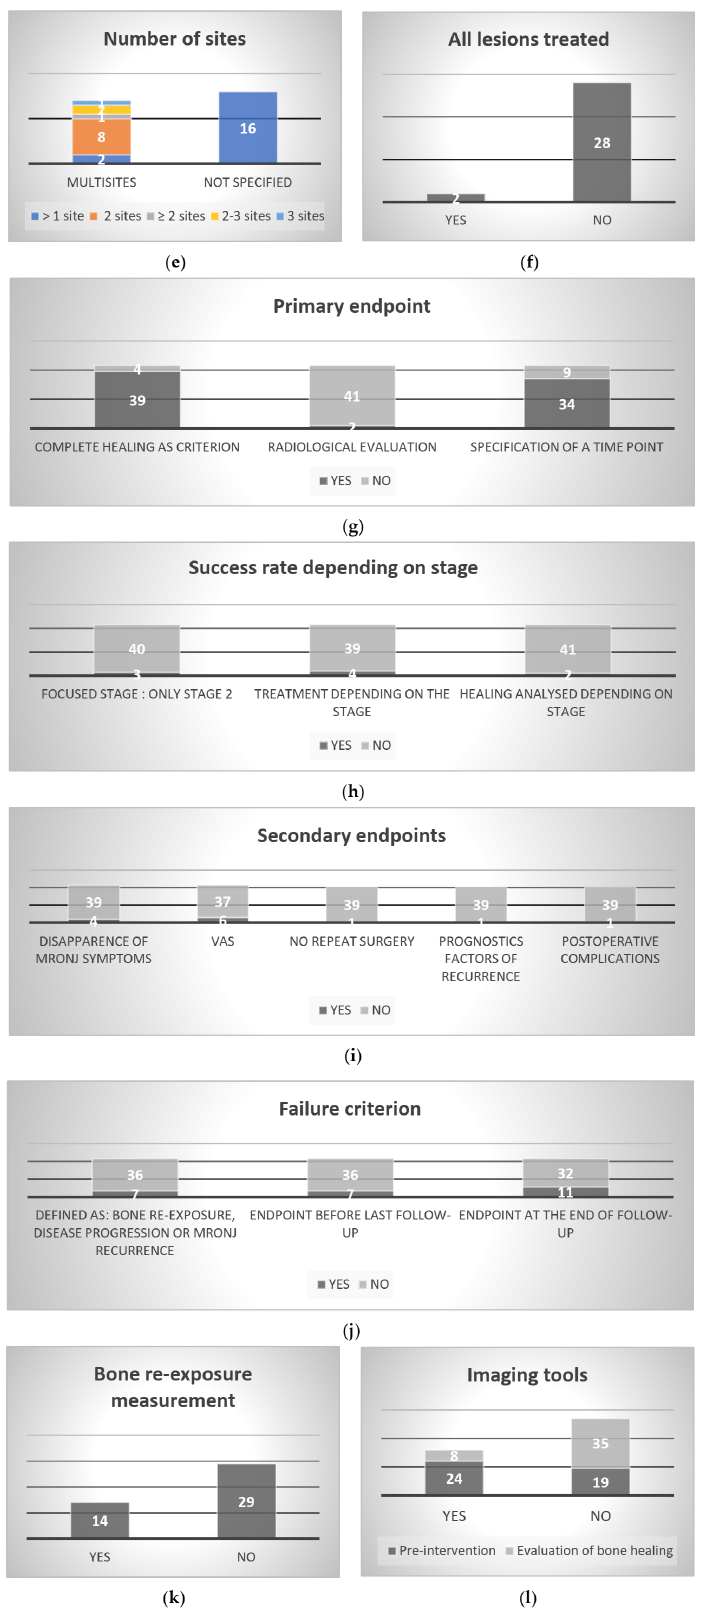
Figure 2. ( a – l ): Summary of the 12 essential criteria and associated missing data. AAOMS: Association of Oral and Maxillofacial Surgeons; MRONJ: medication-related osteonecrosis of the jaw; VAS: visual analog scale; w/o: